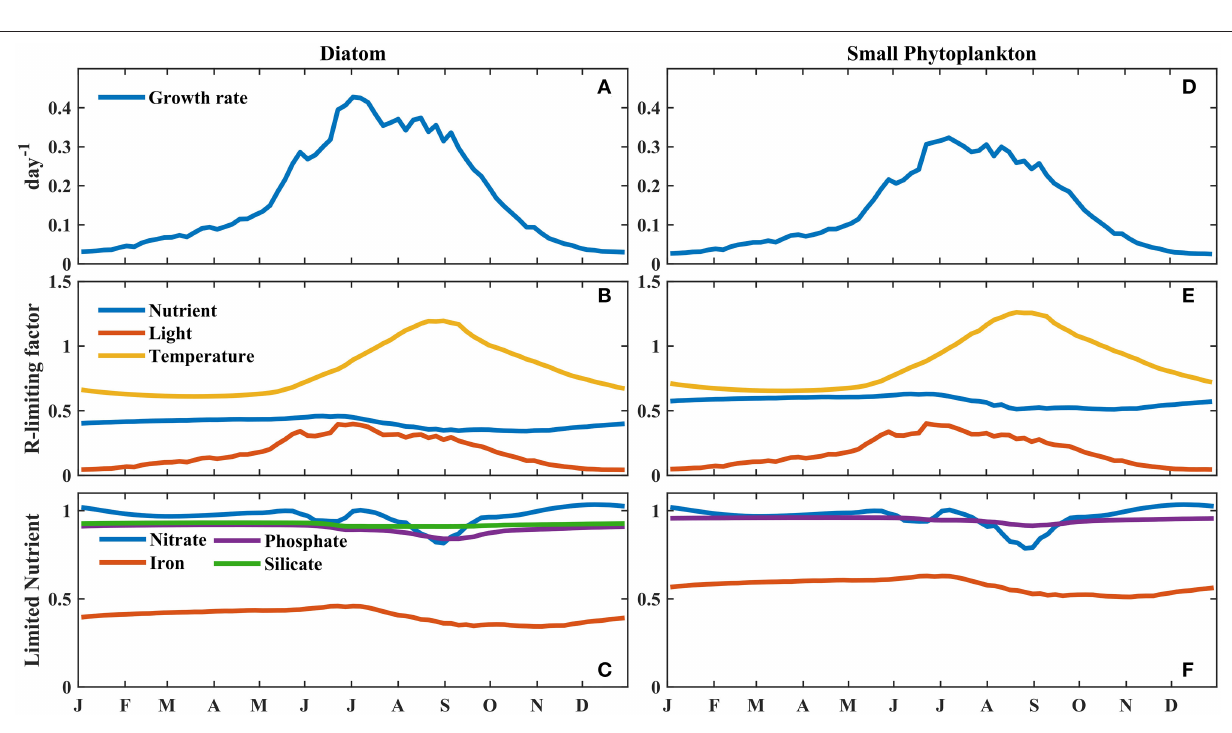
FIGURE 6 | Modeled seasonal cycle of the vertically integrated (A,D) growth rate, (B,E) regulating factors, and (C,F) limiting nutrient factors for phytoplankton, weighted by the phytoplankton biomass at Stn. K2. (A–C) are for small phytoplankton; (D–F) are for